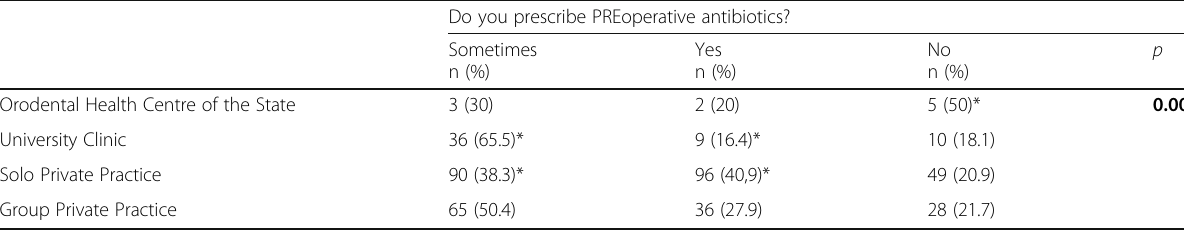
Table 10 Preoperative antibiotic prescribing habit by practice type Do you prescribe PREoperative